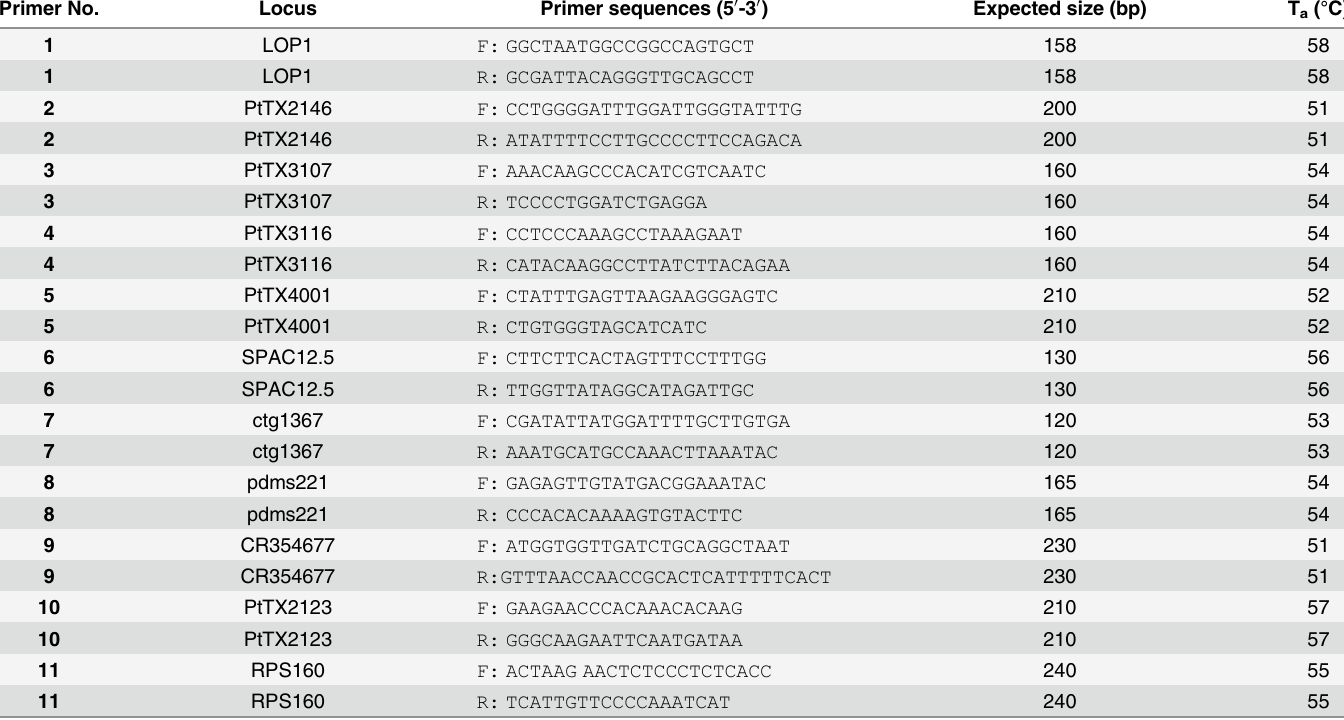
Table 1. Characteristics of the P . tabuliformis polymorphic simple sequence repeat (SSR) primers. Primer No.